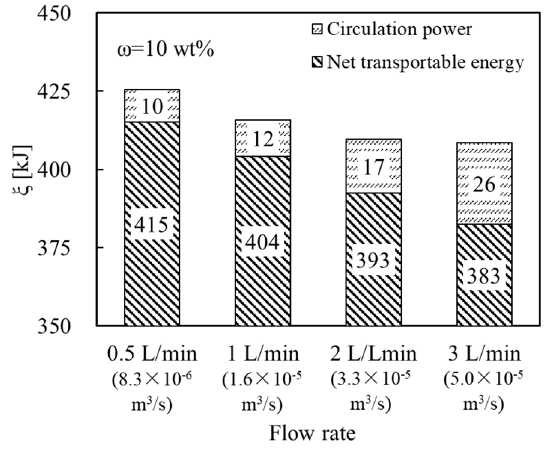
Figure 5. Effects of flow rates on net transportable energy and circulation power at 30 min.